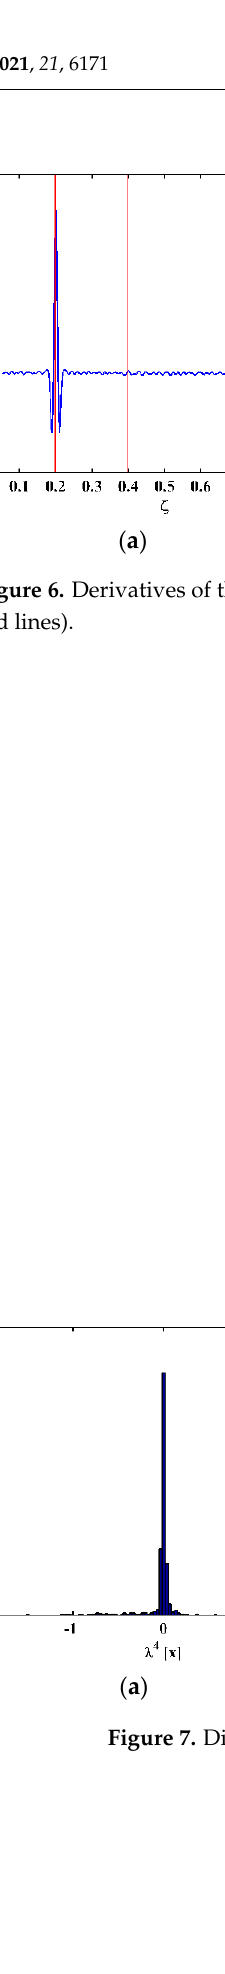
( c ) Figure 8. NMDIs for the ( a ) third, ( b ) fourth, and ( c ) fifth mode shapes (locations of cracks are indicated by red lines). Figure 9. Fused NMDI for multiple crack identification (locations of cracks are indicated by red lines). To explore the ultimate tolerance of the approach against noise interference, SNRs of the mode shapes gradually decrease to 50, 40, and 30 dB to simulate increasingly intensive noise levels. The corresponding fused NMDIs associated with scale parameters 8, 10, and 12 are shown in Figure 10a–c, respectively. It can be seen from Figure 10a,b that, although noise interference increases to cause burrs in the fused NMDIs, three singularity peaks in each fused NMDI can still evidently pinpoint the three cracks. Nevertheless, in Figure 10c,